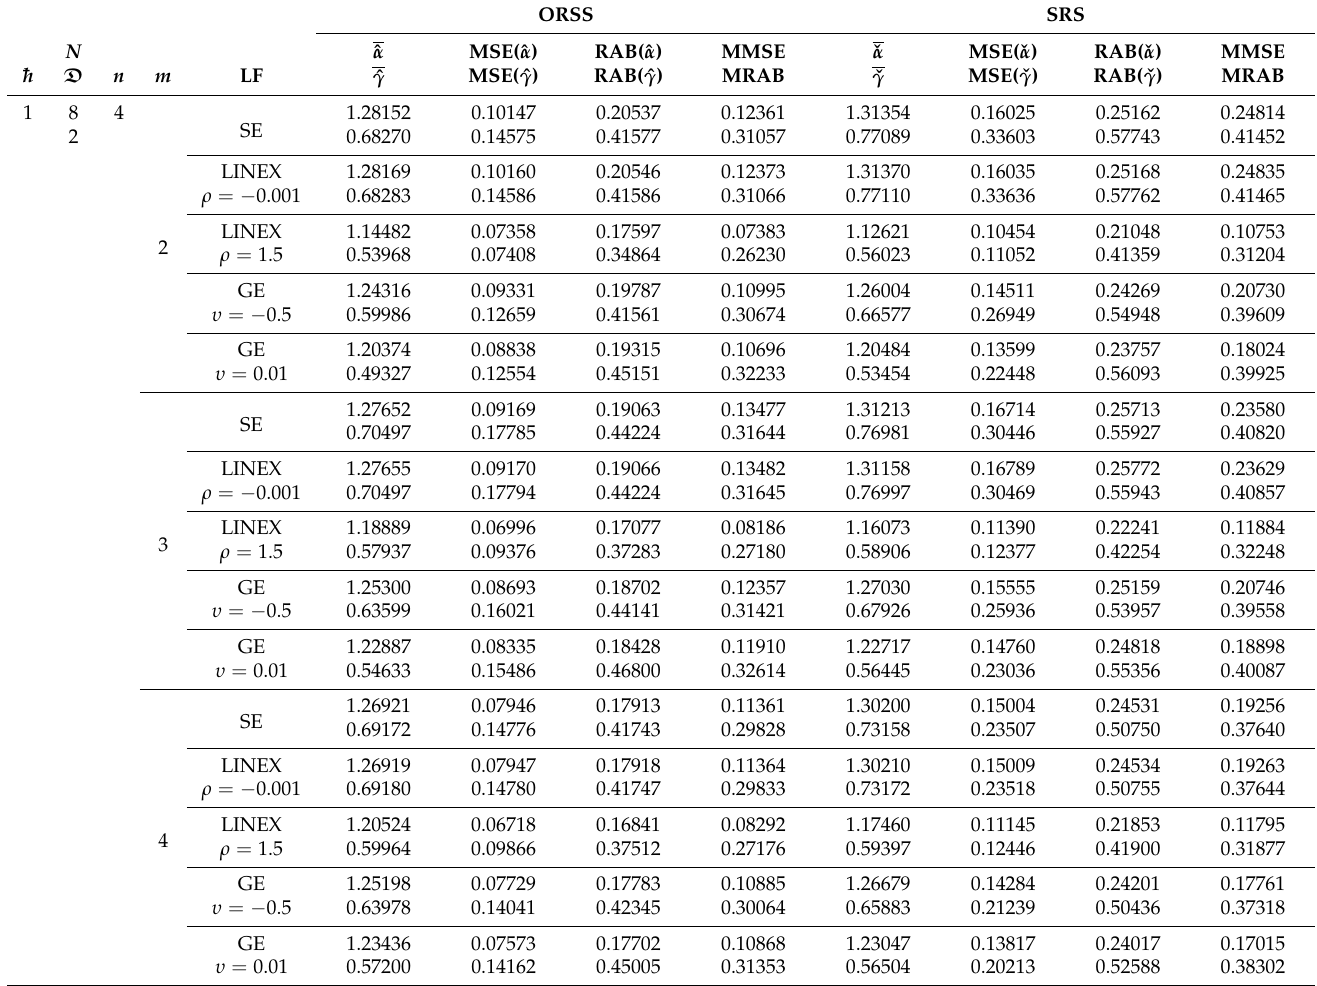
Table A1. BEs of α and γ with their MSEs, RABs, MMSE and MRAB based on 1000 SRSs and ORSSs of size N =